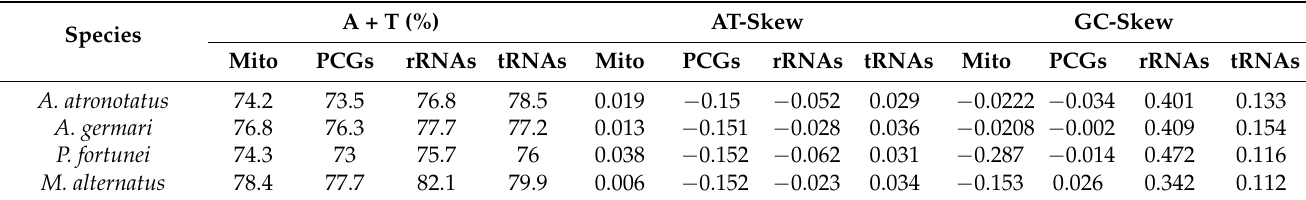
Figure 1. Complete mitochondrial genome structures of Au. atronotatus , Ap. germari , P. fortune and M. alternatus . Genes encoded by the L-strand are underlined whereas those without underline are encoded on the H-strand. Different colored boxes represent different genes. Table 4. Base composition of four Lamiinae mitochondrial genomes.